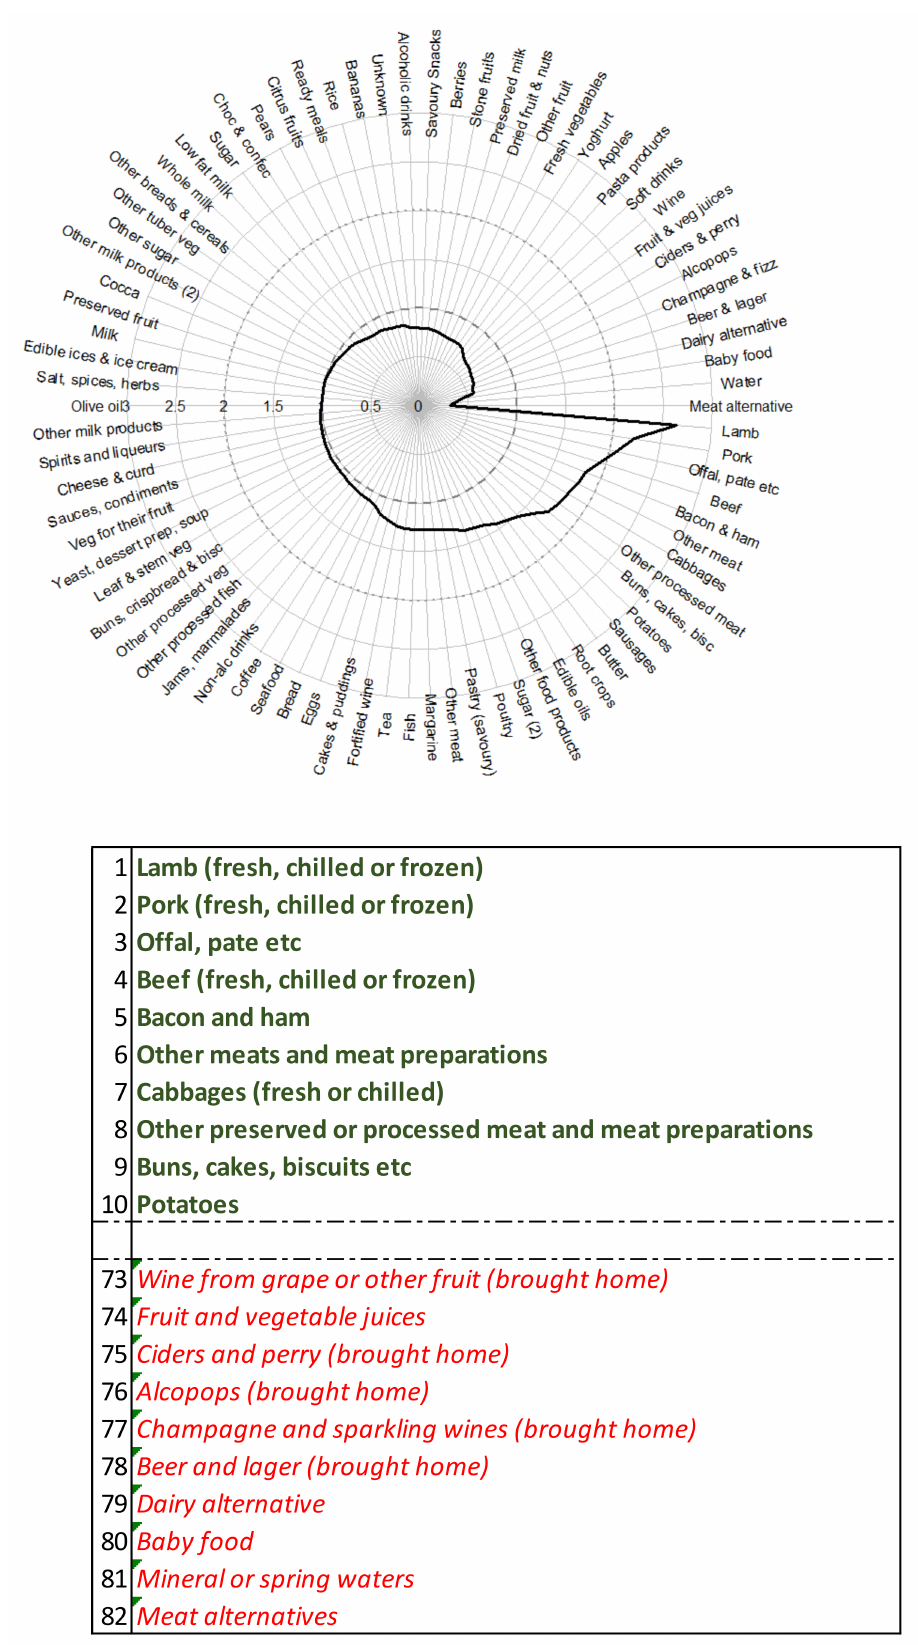
Figure A3. Carnivores ( n =